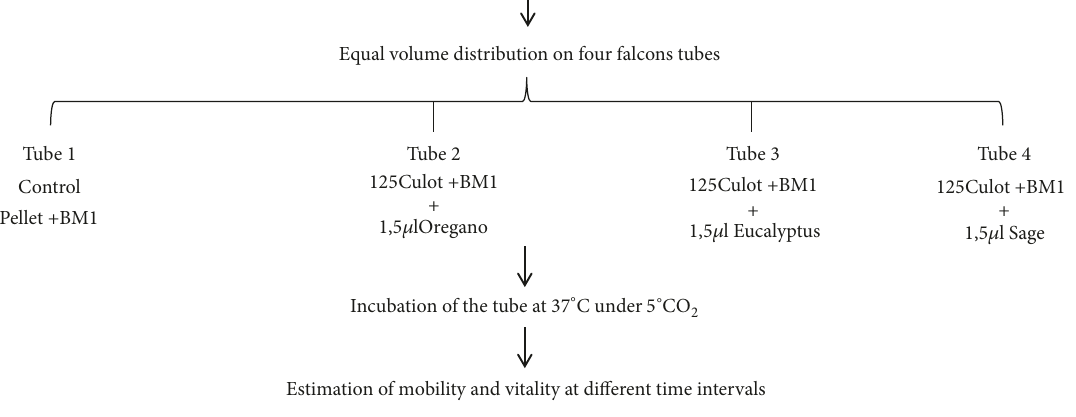
Figure 1: Sample processing treatment